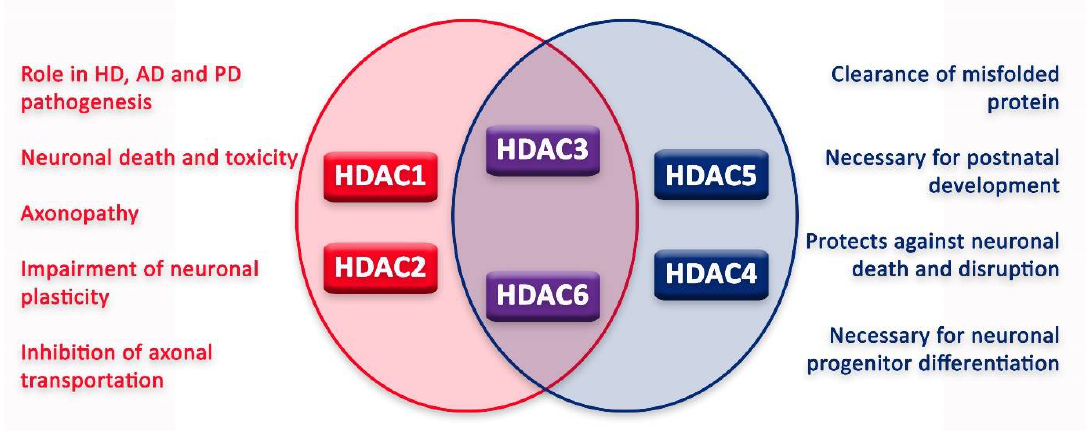
Figure 3. Graphic illustration of roles of HDACs in neurons.